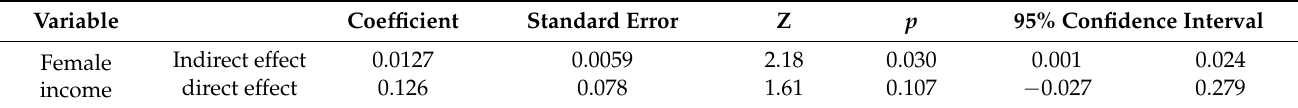
Table 3. Mediating effect analysis of female labor participation and labor income estimated